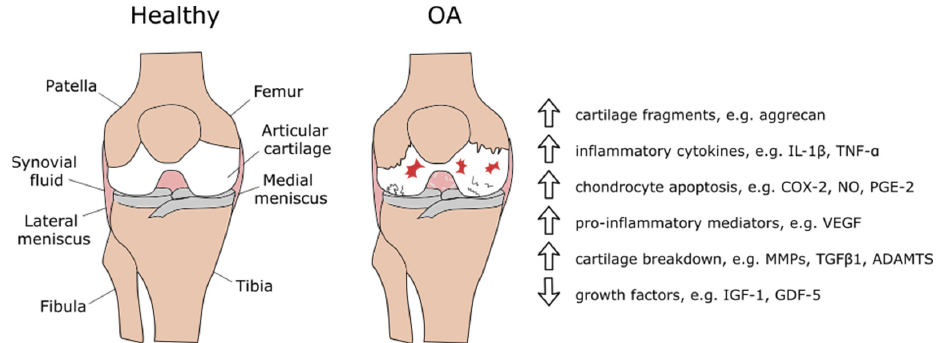
Figure 2. Biochemical changes in knee osteoarthritis.